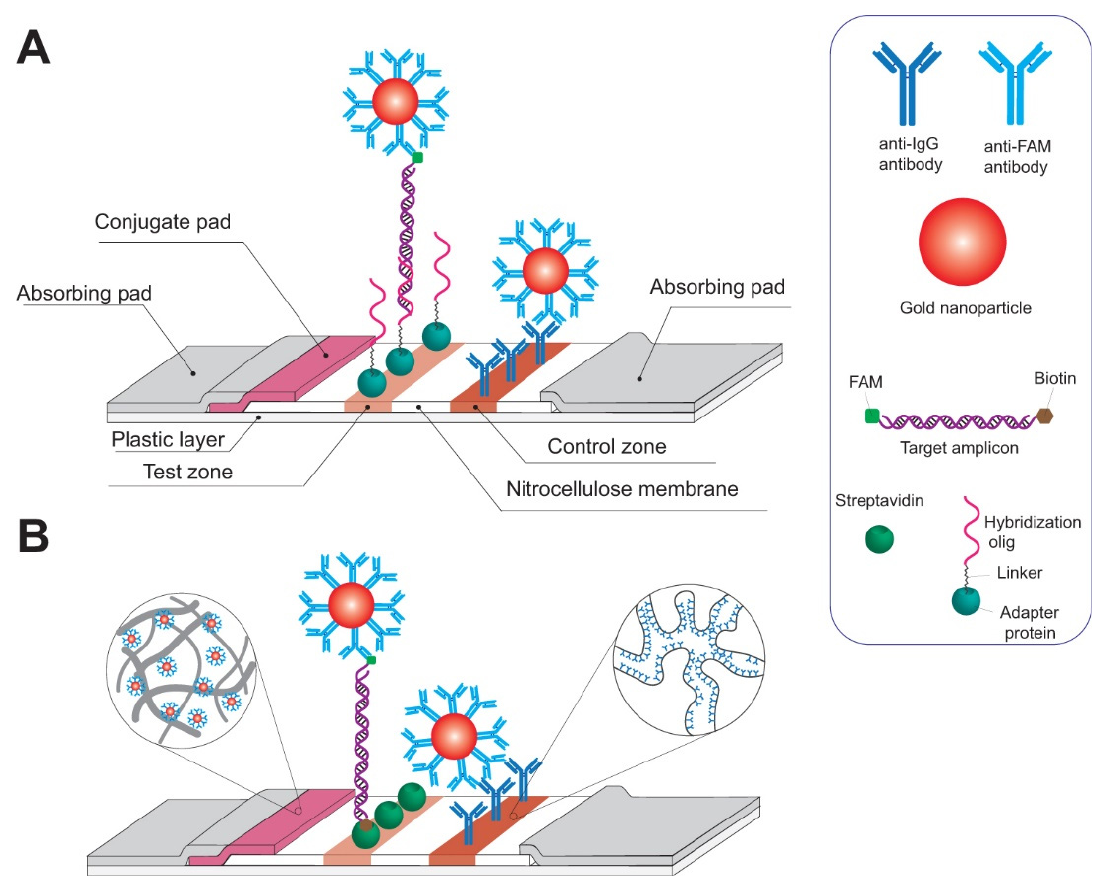
Figure 4. Schematic of a lateral flow assay for detection and visualization of DNA amplification products: direct detection of DNA sequences ( A ) and nucleic acid lateral flow immunoassay ( B ).